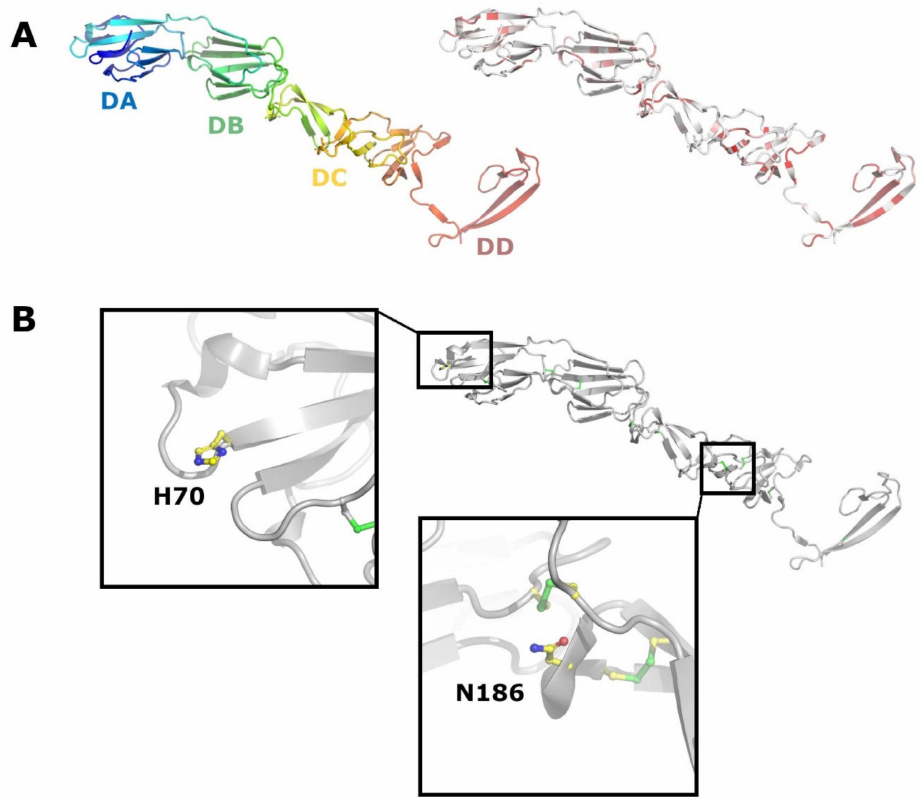
Figure 6. Crystal structure of BVDV E2. ( A ) Cartoon representation of E2 (PDB code 2YQ2). On the left, E2 is coloured from the N terminus (blue) to the C terminus (red). On the right, E2 is coloured according to sequence conservation from white (non-conserved) to red (conserved). ( B ) Residues H70 and N186 from the DA and DD domains respectively, are shown as